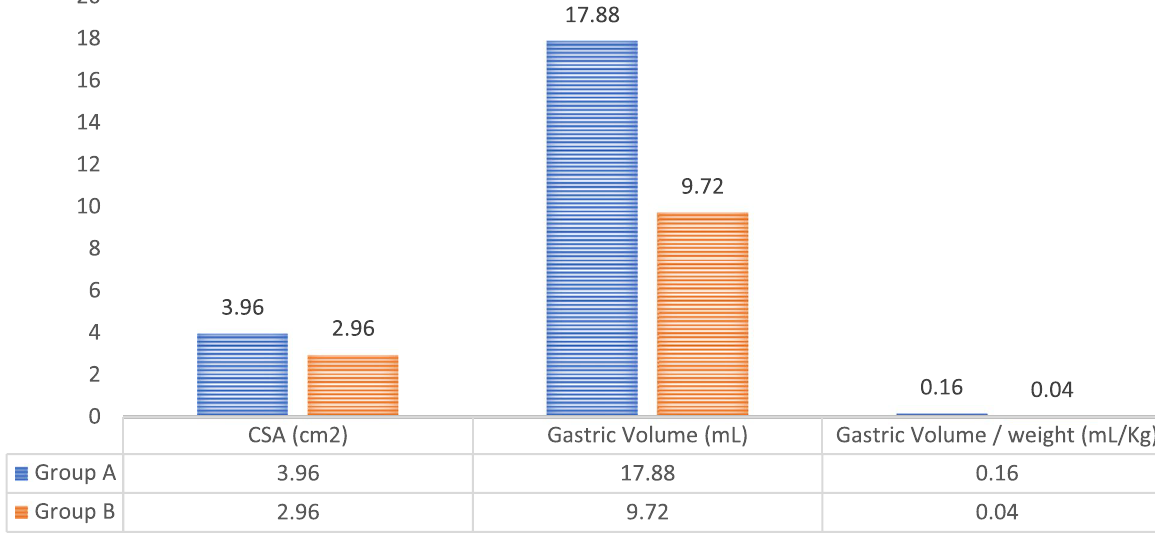
Fig. 3 Comparison of cross-sectional area (CSA), gastric volume (GV) and gastric volume per-kg body weight in diabetic and non-diabetic